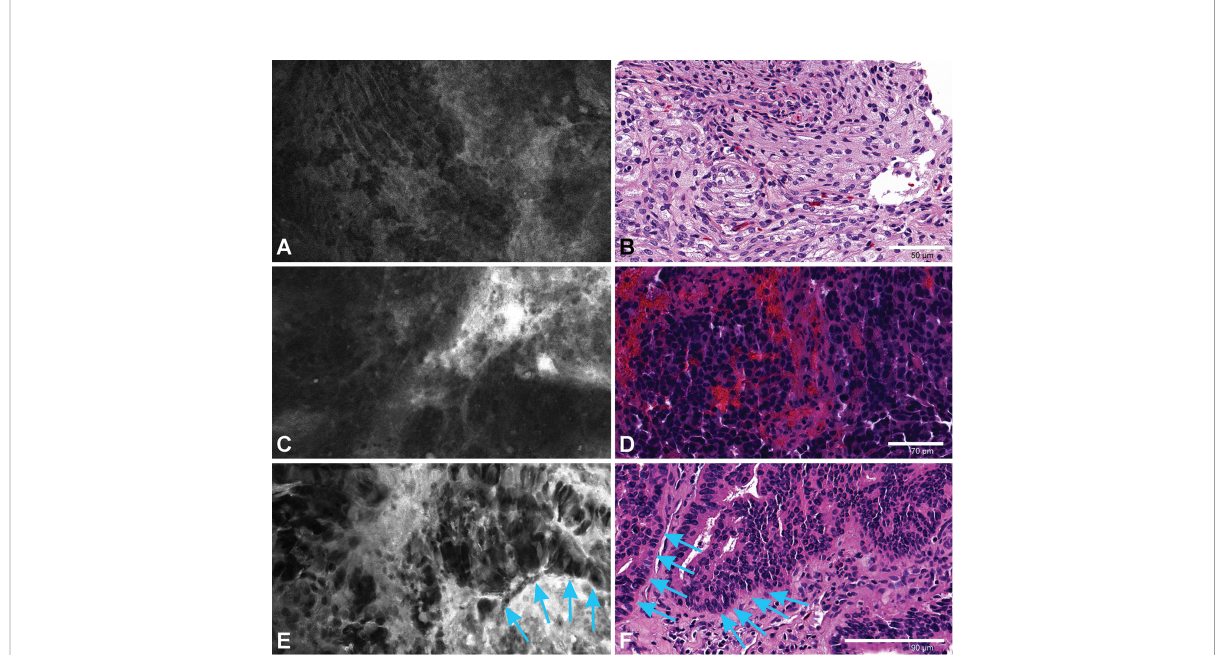
FIGURE 8 An ex vivo meningioma image (A) showing refractile fi bers and a whirling pattern corresponding to the H&E slide (B) . An in vivo image from intracranial metastatic breast carcinoma (C) with nests of highly dense epithelioid cells. H&E slide of the same patient (D) showing tumor cell nests with hemorrhage. An ex vivo image (E) and H&E section (F) from a patient with choroid plexus carcinoma showing tumor cells along the basement membrane ( arrows ). Used with permission from Barrow Neurological Institute, Phoenix,